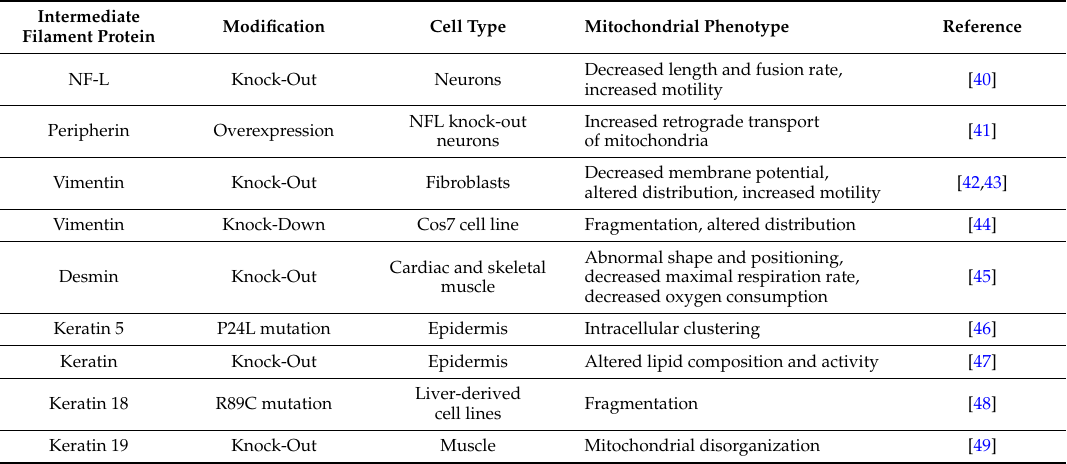
Table 1. List of mitochondrial phenotypes observed in cells and tissues harboring intermediate filament network